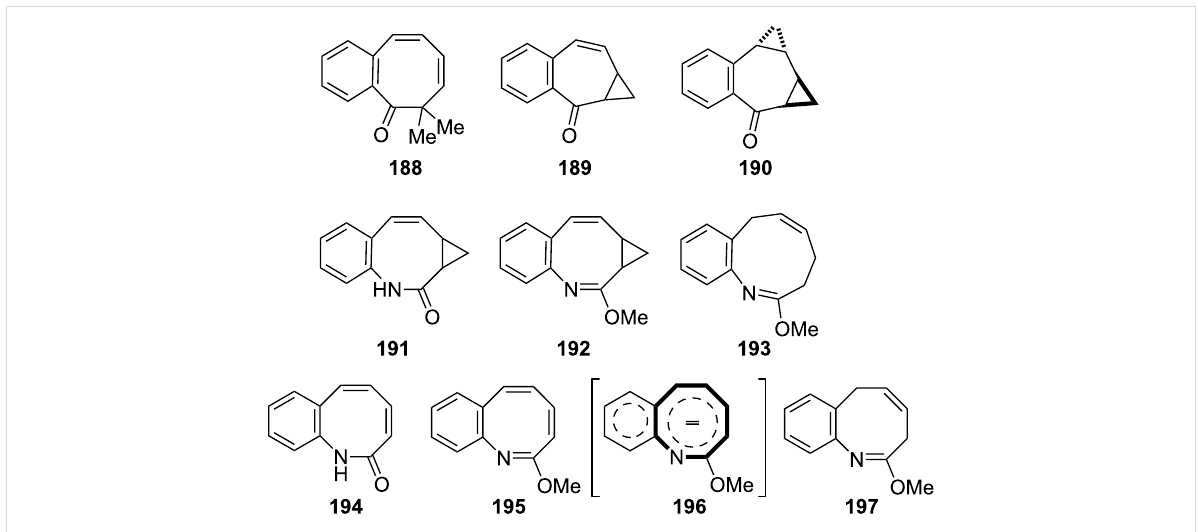
Figure 7: Benzohomoazocines 191 – 193 and benzoazocines 194 – 197